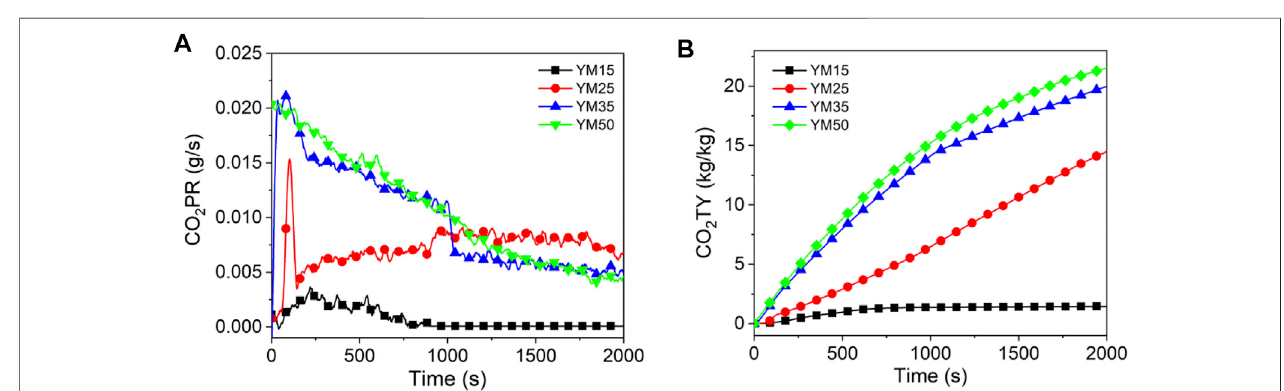
FIGURE 11 | Bitumite curves: (A) PCO 2 PR, and (B) CO 2 TY.